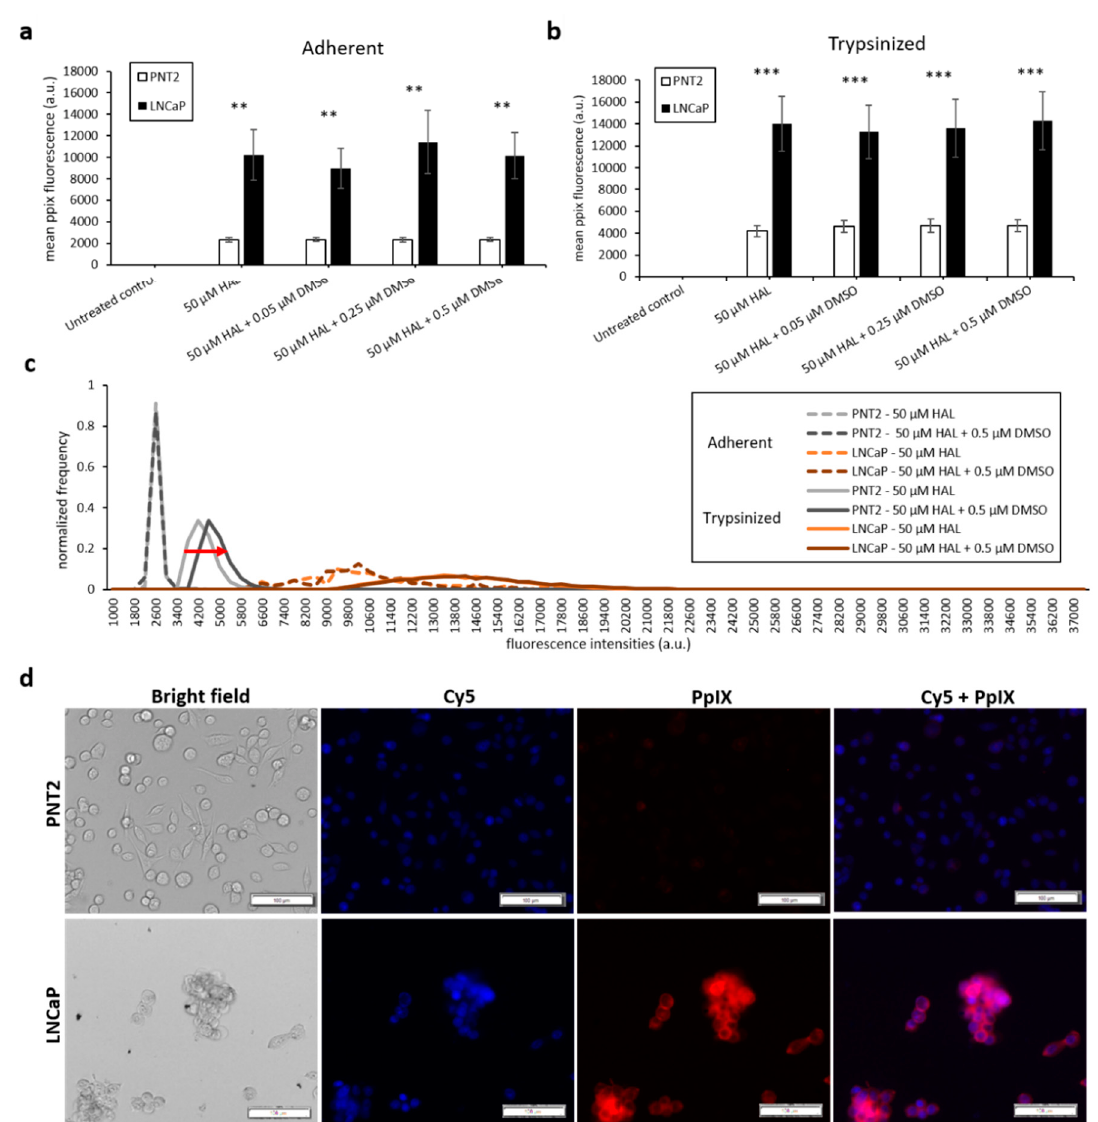
Figure 4. E ff ect of DMSO and HAL treatment on PpIX fluorescence in human prostate cancer LNCaP and human prostate PNT2 cells. Cells were incubated with HAL (50 µ M) alone or HAL (50 µ M) and di ff erent concentrations of DMSO (0.05 to 0.5 µ M) in PBS for 2 h. Mean ± SD ( n = 3), statistical significance by ANOVA. ** p < 0.01 and *** p < 0.001 compared between prostate cancer LNCaP and noncancer prostate PNT2 in the same conditions. PpIX fluorescence was measured in adherent and trypsinised cells. Results are expressed in ( a and b ) bar and ( c ) histogram (50 µ M HAL + 0.05 / 0.25 µ M DMSO not shown) graphs. ( d ) Microscopic images showing the PpIX fluorescence in adherent prostate cancer LNCaP cells after combined treatment with HAL and 0.5 µ M DMSO compared to prostate PNT2 cells (trypsinised cells images not shown). Scale bars represent 100 µ m, magnification is 10X. Thus, adding DMSO to trypsinised cells decreased the contrast between cancer and healthy cells. Using 0.25 µ M DMSO with HAL produced more PpIX fluorescence in adherent LNCaP